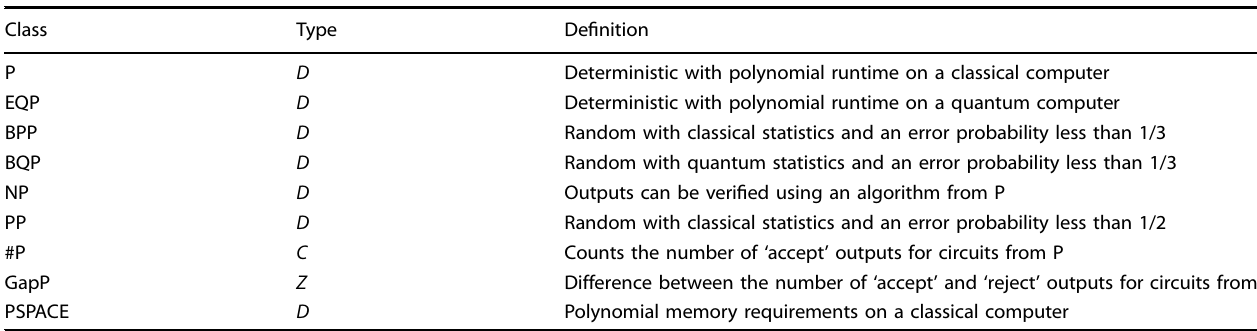
Table 1. De fi nitions of complexity classes used in this review